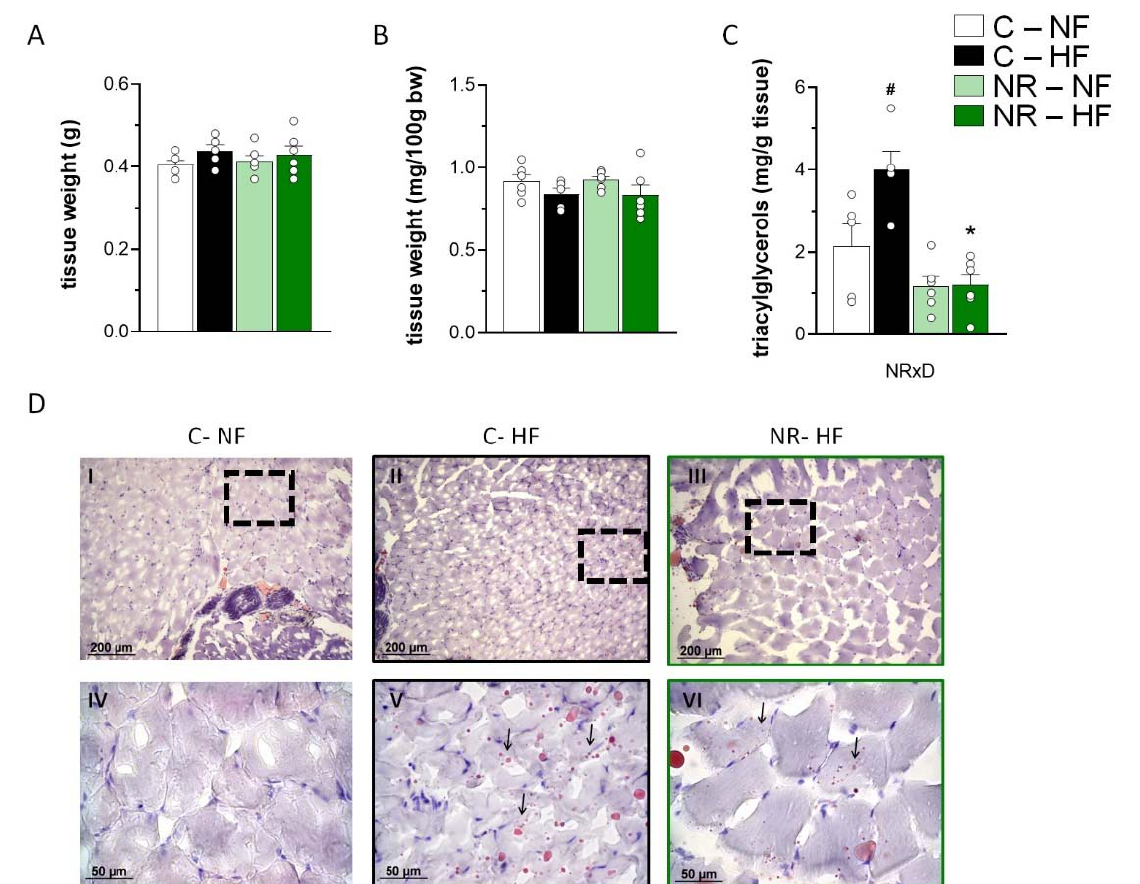
Figure 1. Early-life nicotinamide riboside (NR) treatment protected against high-fat (HF) diet-induced triacylglycerol accumulation in skeletal muscle in adulthood. Newborn male mice received NR or vehicle (water; control) from day 2 to 20 of age, were weaned onto a chow diet on day 21, and were assigned to either an HF or a normal-fat (NF) diet on day 90 for 10 weeks. Gastrocnemius muscle weight ( A ), weight as a percentage of body weight ( B ), and triacylglycerol content ( C ) at the end of the experiment. Data are the mean ± SEM of 5–6 animals per group. Circles correspond to individual data. Statistics ( p < 0.05): NRxD treatment per diet interaction (two-way ANOVA); * NR vs. control, # HF vs. NF ( t -Student). In ( D ), representative Oil Red O staining of Gastrocnemius muscle sections of indicated experimental groups are shown (panels I-III), together with corresponding magnification of indicated areas in boxes (panels IV-VI). Arrows in images denote intramyocellular neutral lipid